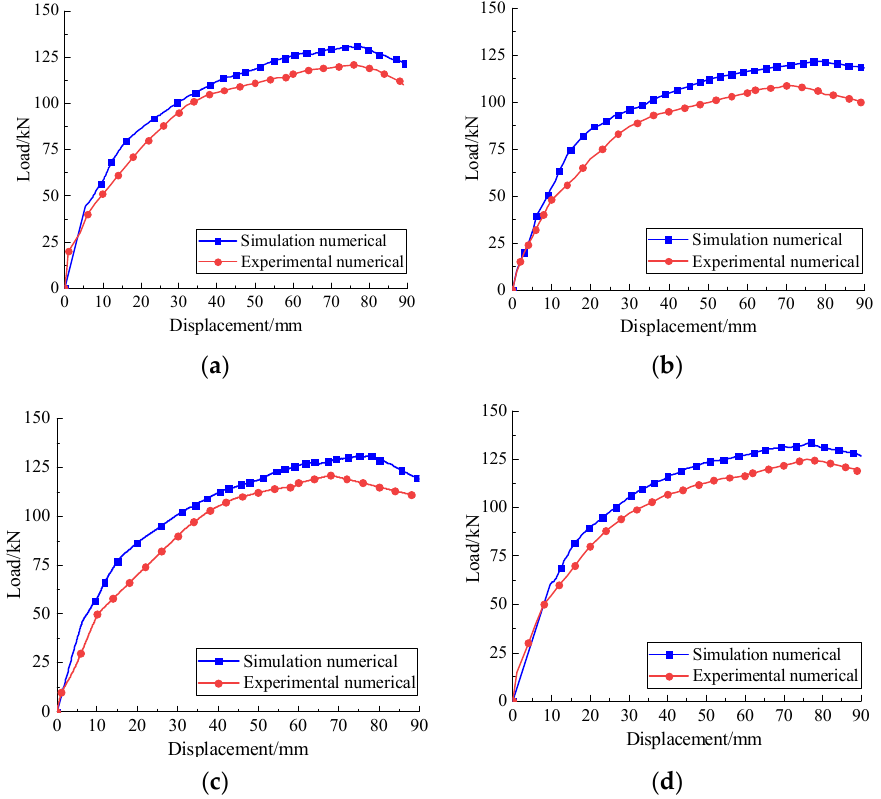
Figure 13. Finite-element analysis and test load-deflection curves: ( a ) SP-1; ( b ) SP-2; ( c ) SP-3; ( d ) SP-4.